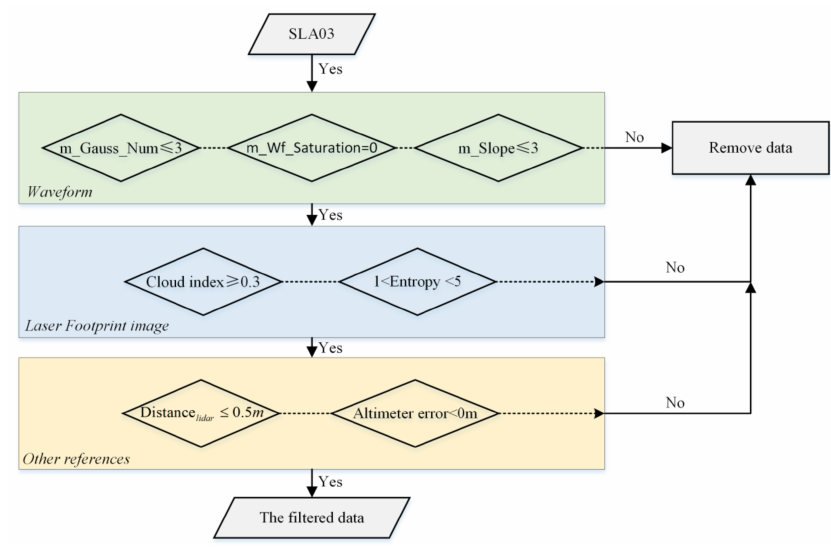
Figure 11. Atmospheric scattering identification process for land areas.